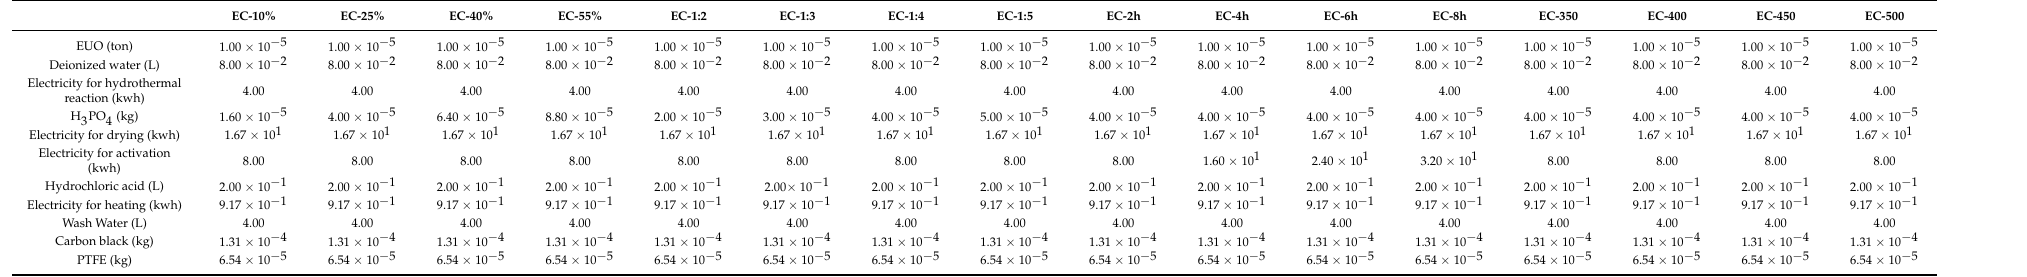
Table 1. The electricity consumption and material used for different process